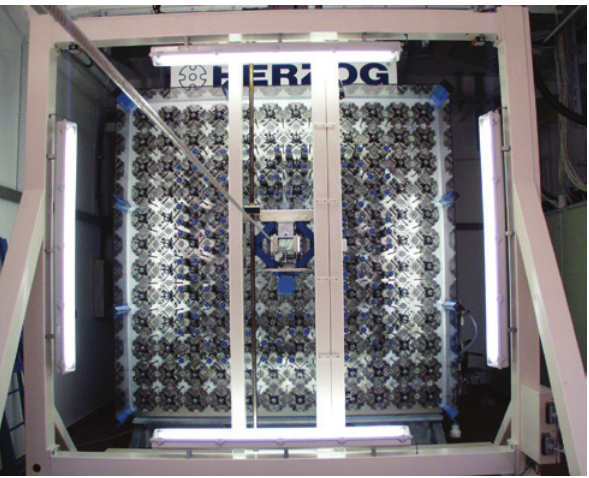
Figure 6: 3D braiding facility from Herzog Maschinenfabrik GmbH with a rectangular grid of horn gears. Source: RWTH Aachen.